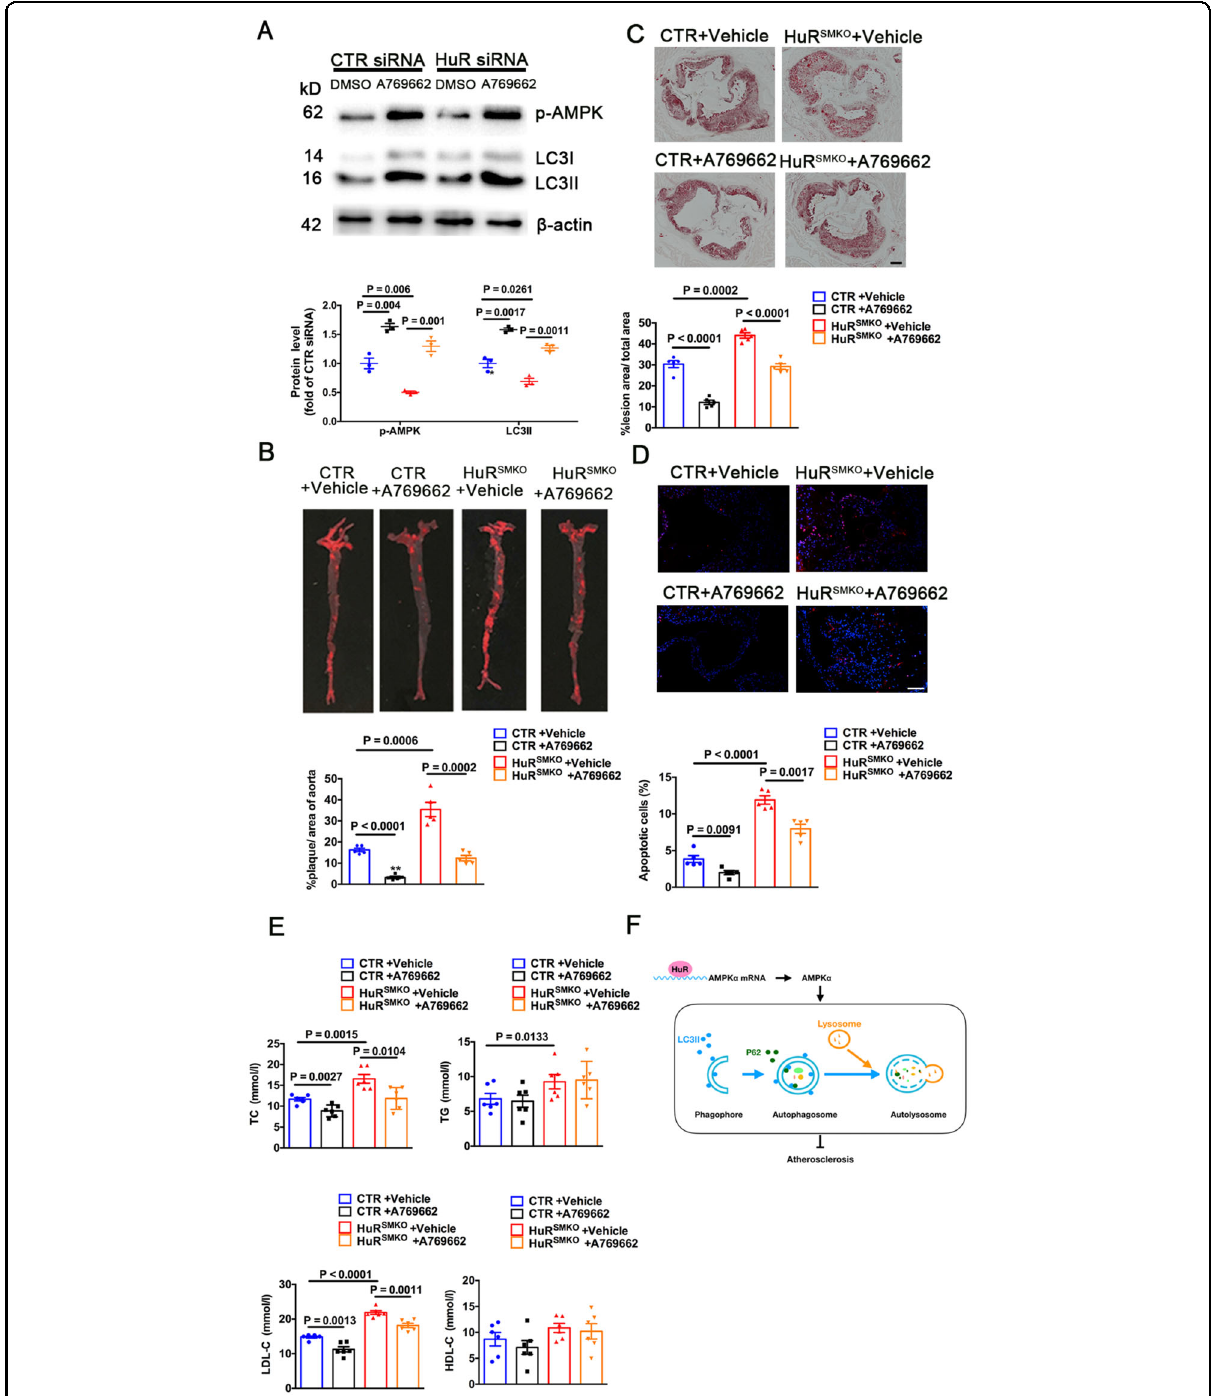
Fig. 7 Pharmacological AMPK activation induced autophagy and suppressed atherosclerosis in HuR SMKO mice. A Western blot analysis of VSMCs transfected with CTR or HuR siRNA for 48 h, then treated with 200 μ M A769662 for 1 h ( n = 5). CTR and HuR SMKO mice were single injected with rAAV/D377Y-mPCSK9, then intraperitoneally injected with 30 mg/kg A769662 daily and fed a Paigen diet for 12 weeks. B Oil-red O staining in aortas ( n = 5). C Oil-red O staining in aortic roots ( n = 5). Scale bar = 200 μ m. D TUNEL staining in aortic roots ( n = 5). Scale bar = 50 μ m. E TC, TG, HDL-C, and LDL-C levels ( n = 6). F Diagram for the role of smooth-muscle HuR in atherosclerosis via AMPK-mediated autophagy. HuR indicates human antigen R; AMPK, Adenosine 5 ′ -monophosphate-activated protein